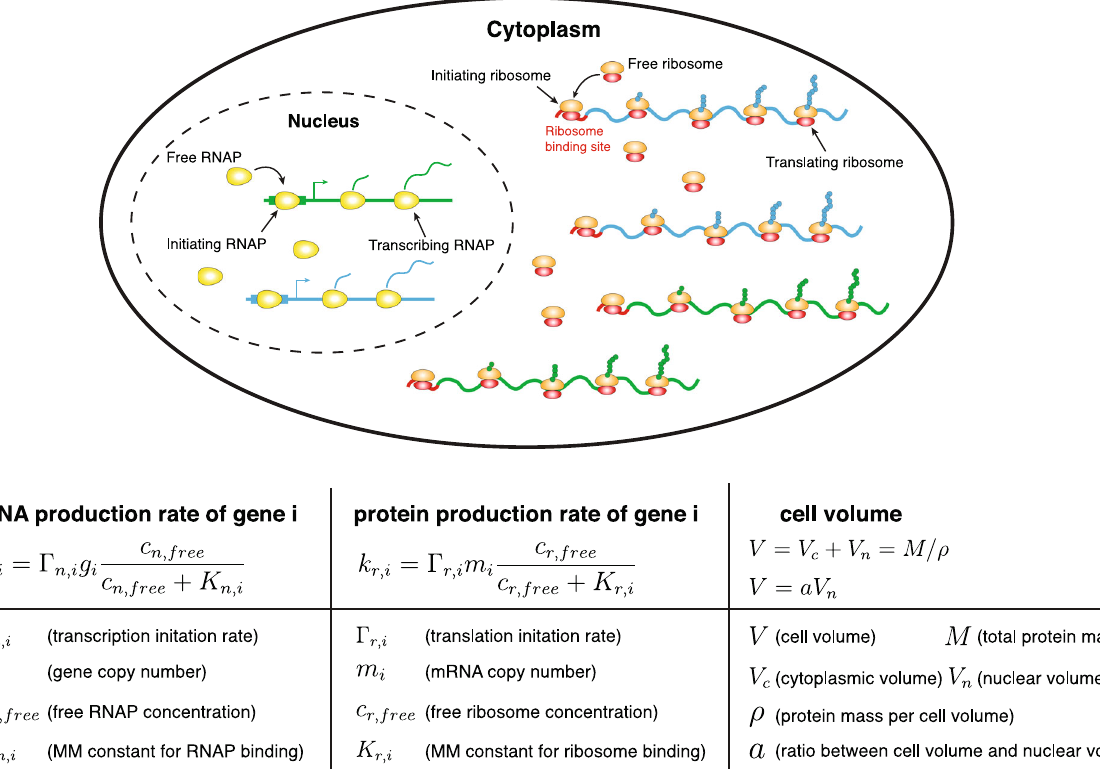
Fig. 1 A coarse-grained model of gene expression at the whole-cell level. Inside the nucleus, genes compete for free RNAPs to bind to their promoters and for simplicity we only show two genes in this schematic. The binding probability of free RNAPs to the promoters depends on the free RNAP concentration and the recruitment abilities of the promoters. In the cytoplasm, mRNAs compete for free ribosomes to bind to their ribosome binding sites and the binding probability depends on the free ribosome concentrations and the recruitment abilities of the mRNAs to ribosomes. The cell volume V , which includes the cytoplasmic volume ( V c ) and nuclear volume ( V n ), is proportional to the total protein mass M . The ratio between the nuclear volume and cell volume is